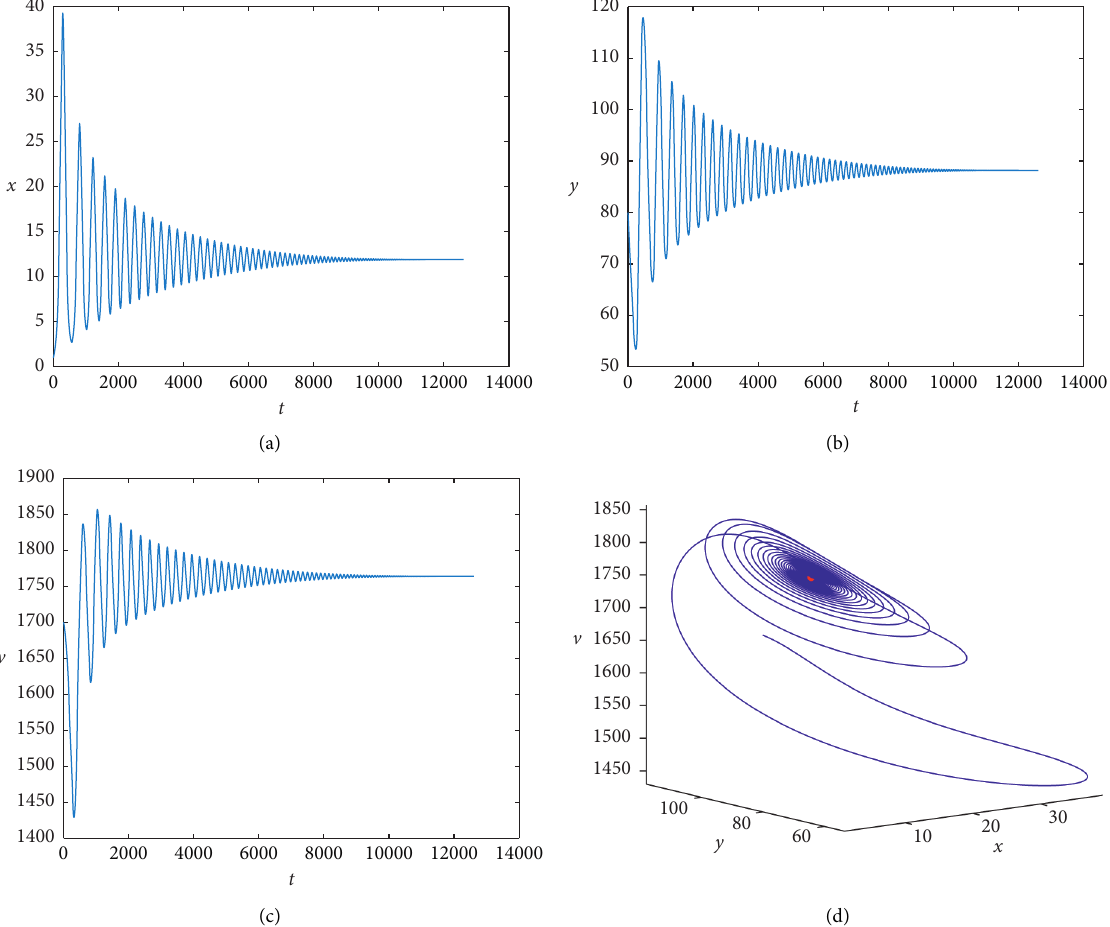
Figure 4: Illustration of basic behavior of solutions of system (4) with τ � 0 . 52 < τ (a) time series of x ( t ), (b) time series of y ( t ), (c) time series of v ( t ), and (d) phase trajectories of x ( t ), y ( t ), and v ( t